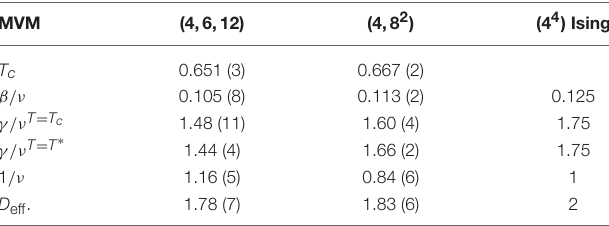
TABLE 1 | Critical temperatures, exponents and effective dimensionalities for MVM on (4,6,12) and (4,8 2 ) AL [ 22].